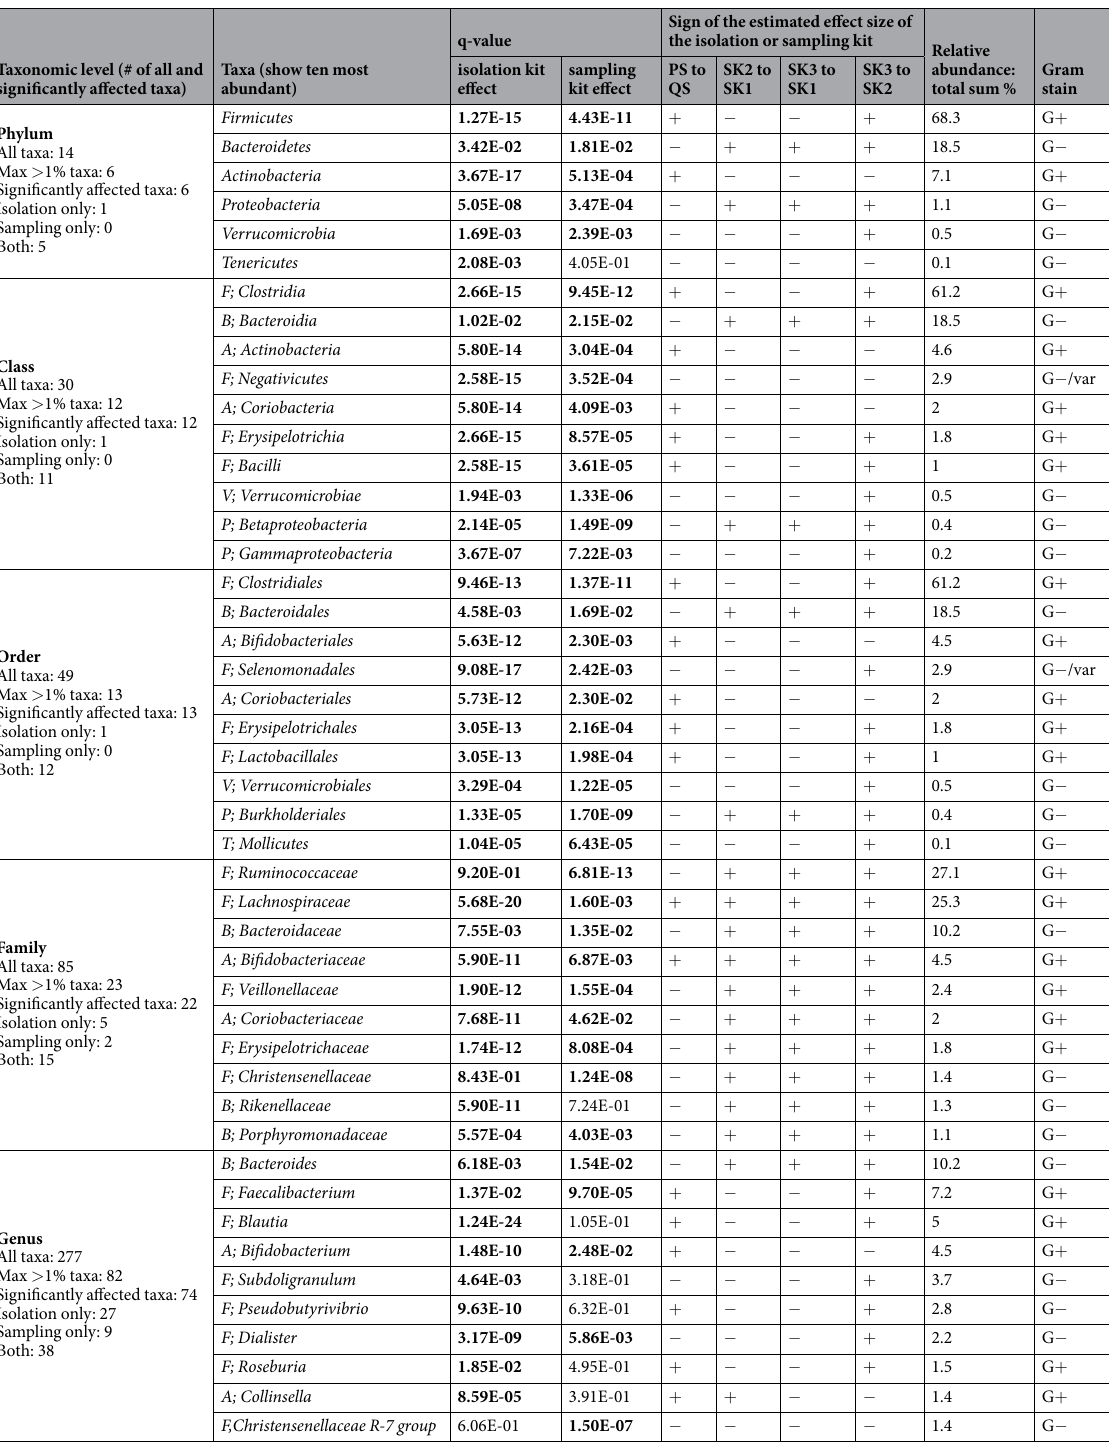
Table 1. Summary of taxa at all levels and detailed results for top 10 taxa significantly affected by sampling or DNA isolation kit. The significant q - values are shown in bold. SK1- stool container; SK2 – flocked swabs; SK3 - cotton swabs; PS – PowerLyzer PowerSoil DNA Isolation Kit; QS - QIAamp DNA Stool Mini Kit. All taxa – number of taxa found at the respective taxa level; Max > 1% taxa – number of taxa that fulfilled the selection criteria for the analysis; Significantly affected taxa – the overall number of taxa at the respective taxa level affected by the isolation or sampling kit; Isolation only – number of taxa at the respective taxa level affected by the isolation kit only; Sampling only – number of taxa at the respective taxa level affected by the sampling kit only; Both – number of taxa at the respective taxa level affected by both sampling and isolation